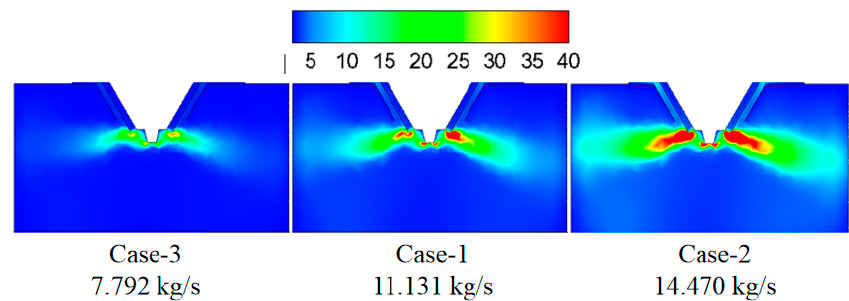
Figure 4. Turbulence kinetic energy under different flue gas flow rates (m 2 /s 2 ).